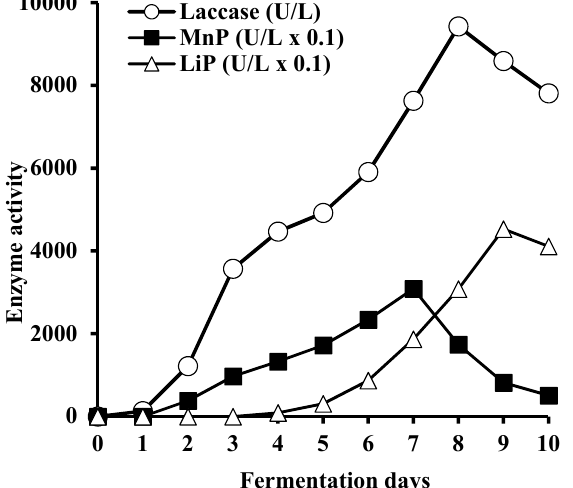
Figure 4. LME activities during cultivation of C. gallica 142 in bioreactor.